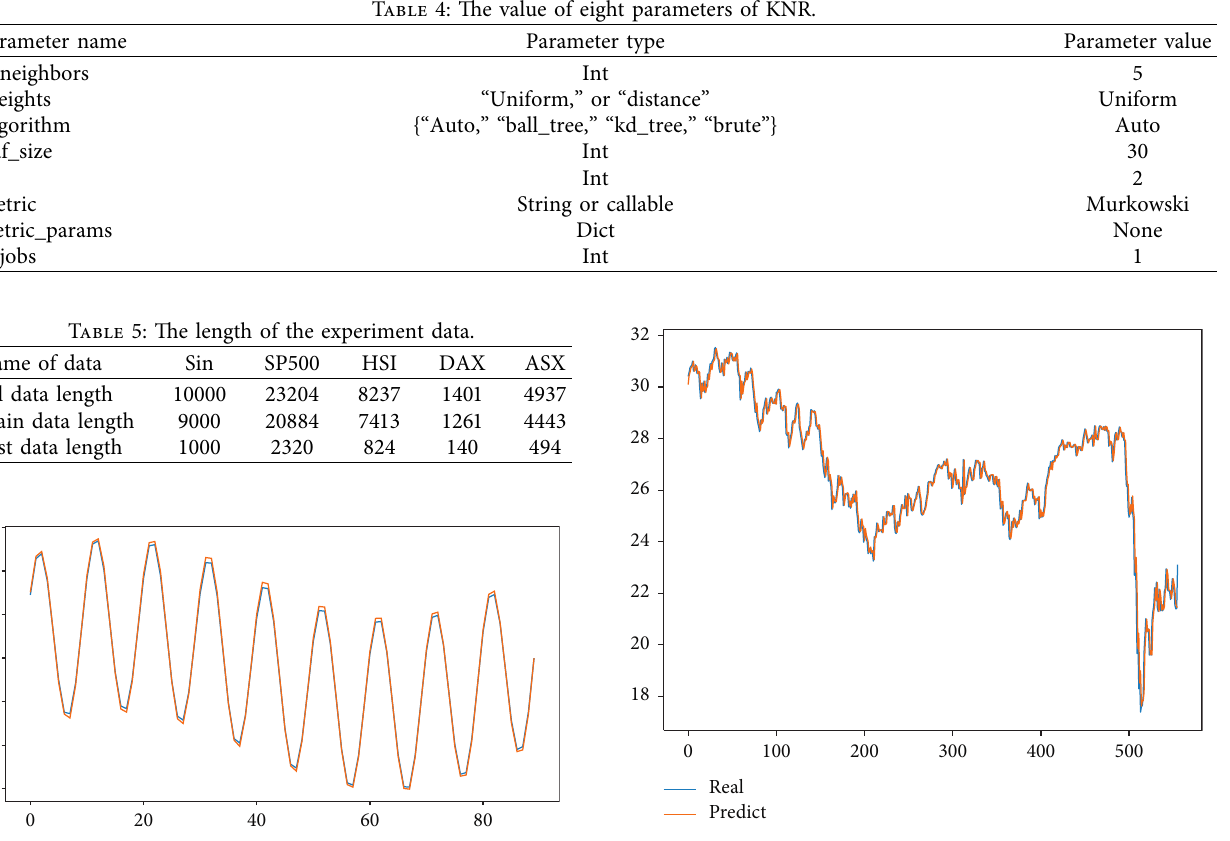
Figure 11: Prediction results of BARDR for DAX